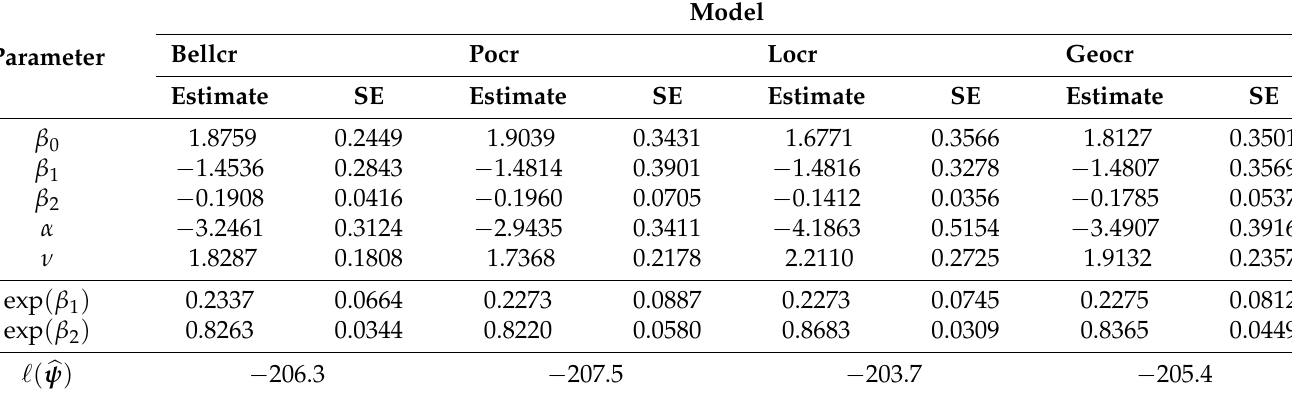
(cid:0) (cid:96) ( (cid:1) for (cid:98) ψ )